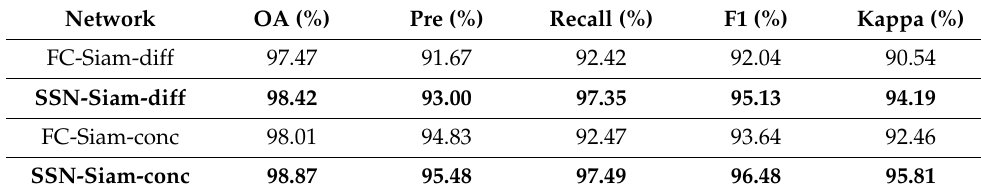
Table 3. Quantitative results of Ottawa dataset for models with SSN or without.